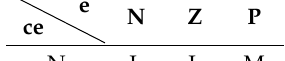
Table 3. Rules for fuzzy—Rule 1.